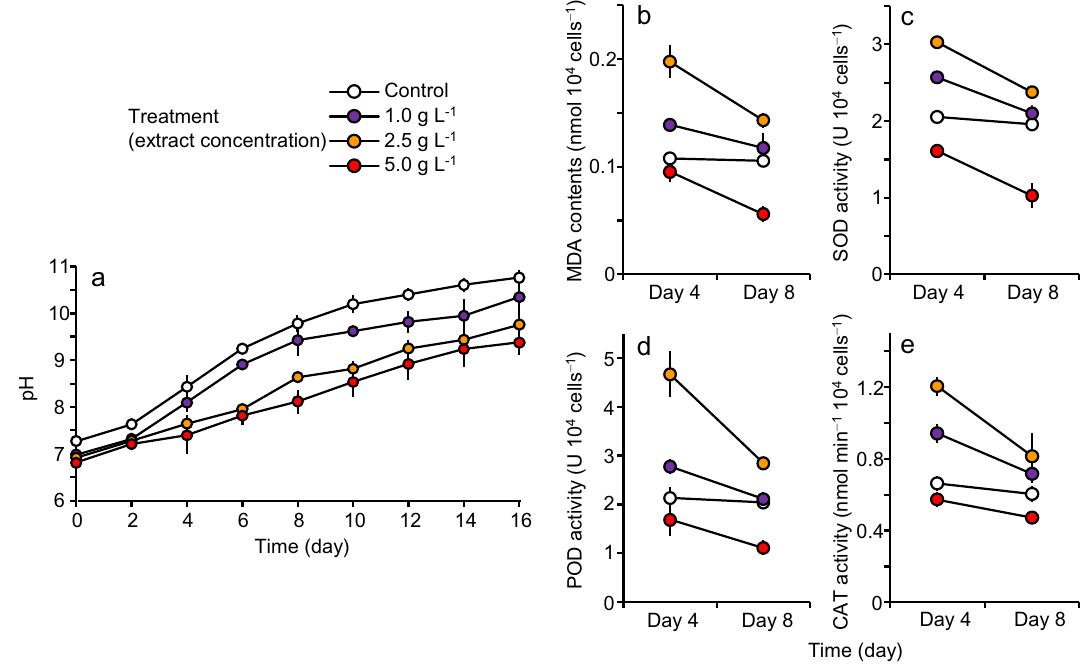
Figure 2. Changes in pH ( a ), malondialdehyde (MDA) content ( b ), superoxide dismutase (SOD) activity ( c ), peroxidase (POD) activity ( d ), and catalase (CAT) activity ( e ) in Microcystis aeruginosa mono-species culture. Error bars are SD ( n =